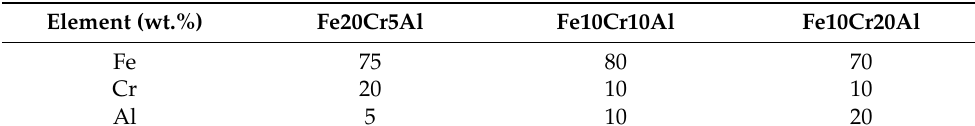
Table 1. Compositions of the studied Fe-Cr-Al alloys. Element (wt.%)